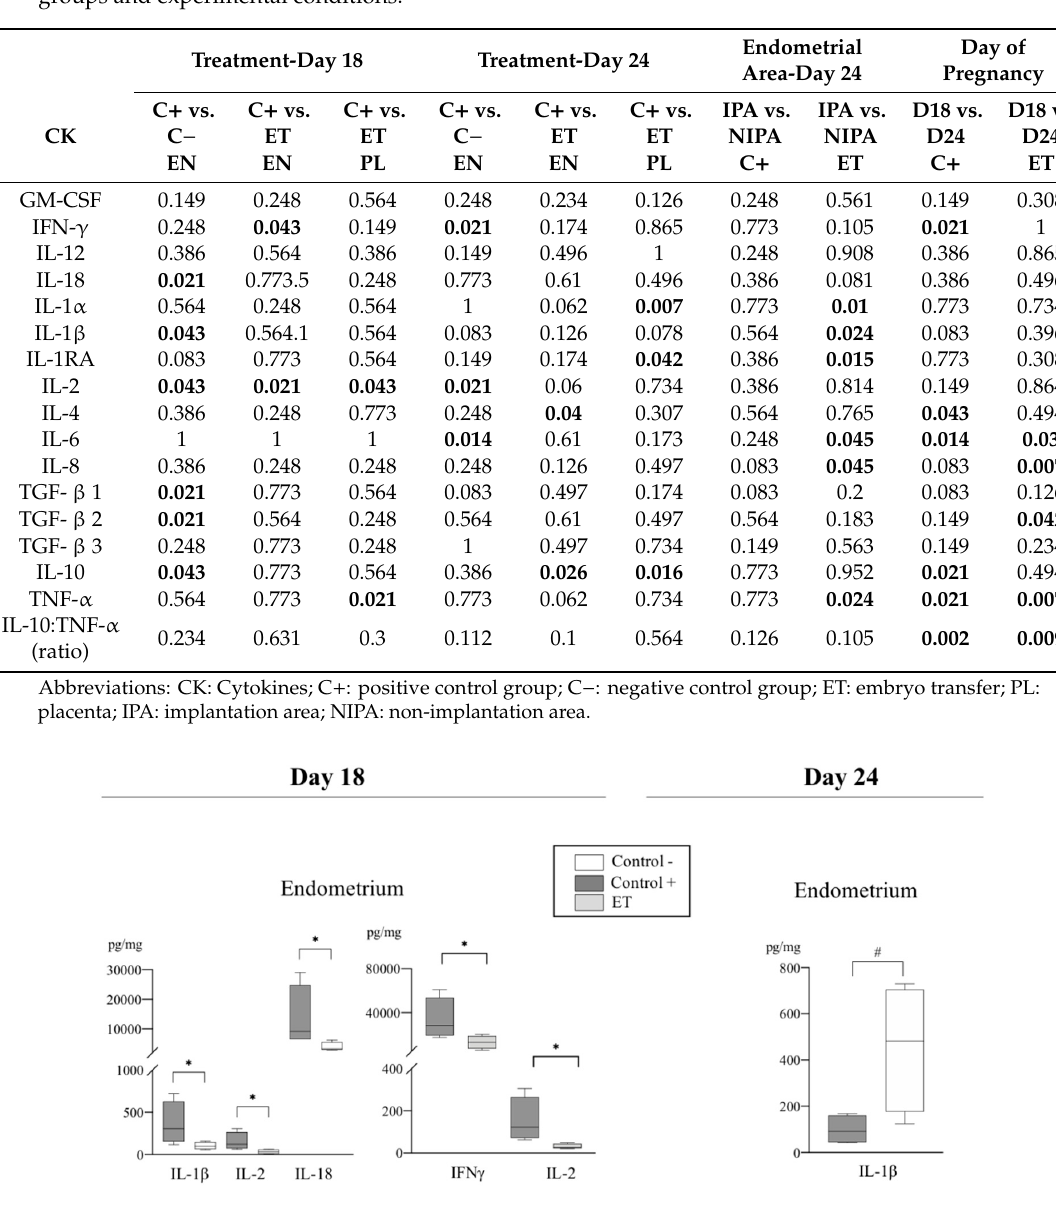
Figure 4. Relative abundance of pro-inflammatory cytokines (pg/mg of total protein) in ET group between days ( A ) and endometrial areas ( B ). Data are presented by box plot showing median and interquartile range (Q1–Q3). Asterisks indicate significant differences among groups (* p < 0.05; *** p < 0.001).